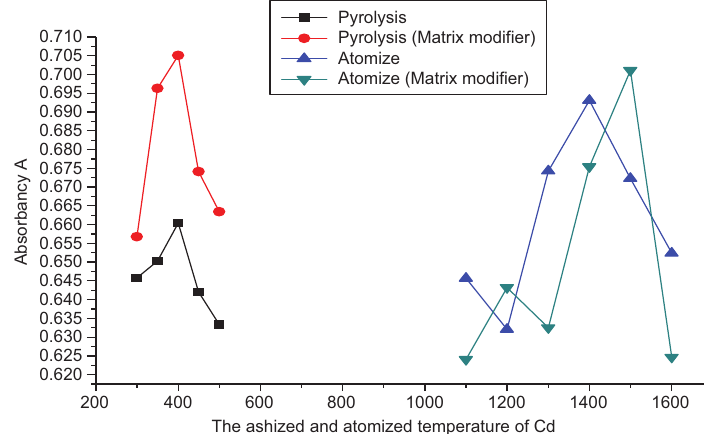
Figure 2 Ashing temperature and atomization temperature of cadmium.